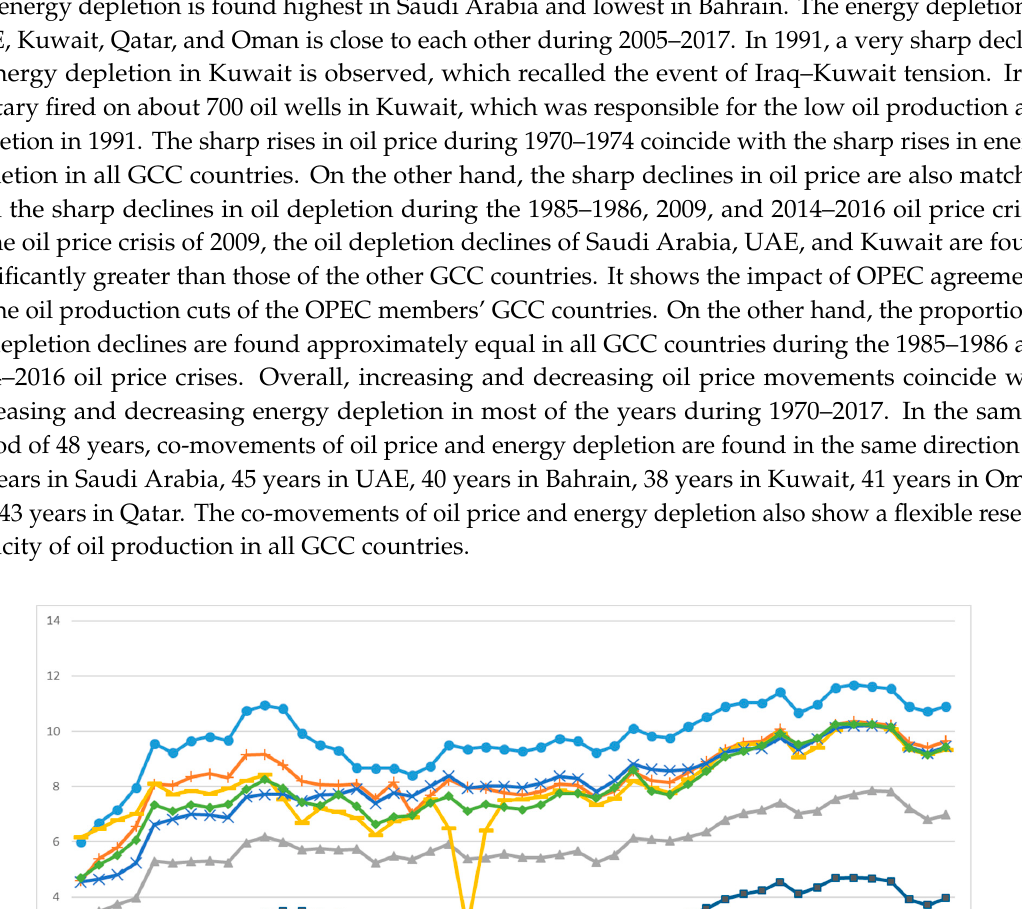
Table 1. Dickey–Fuller generalized least square (DF-GLS) test.